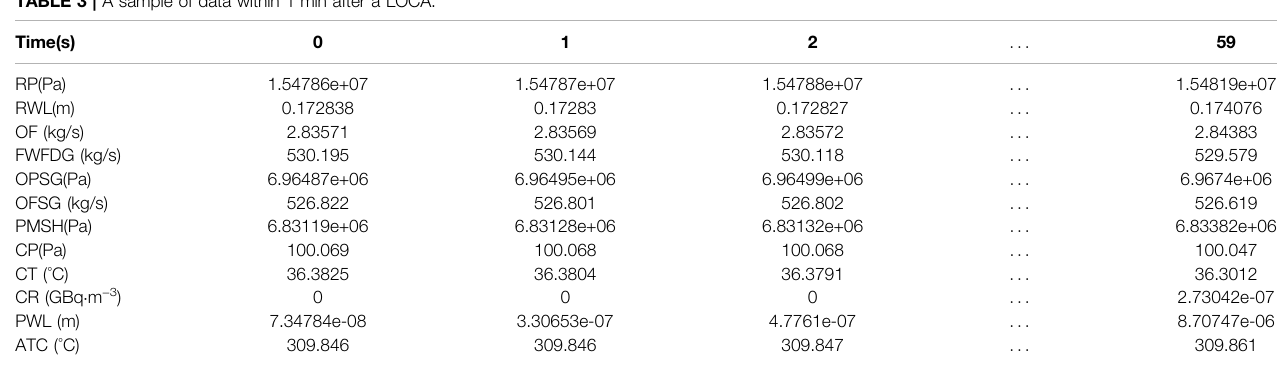
TABLE 3 | A sample of data within 1 min after a